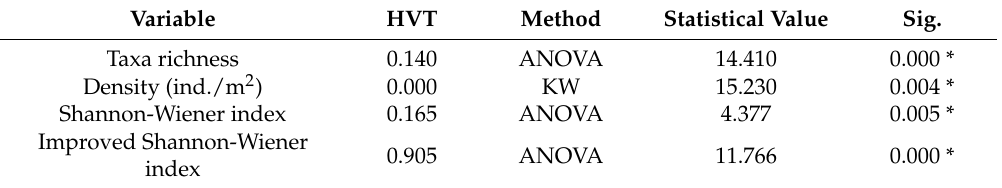
Table 3. Global variation of the alpha diversity indices among all of the sampling sites in the five